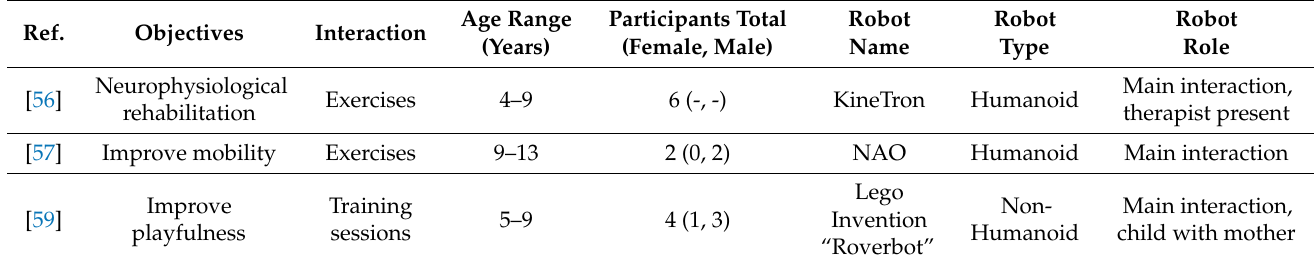
Table 3. Quantitative information of the examined studies with cerebral